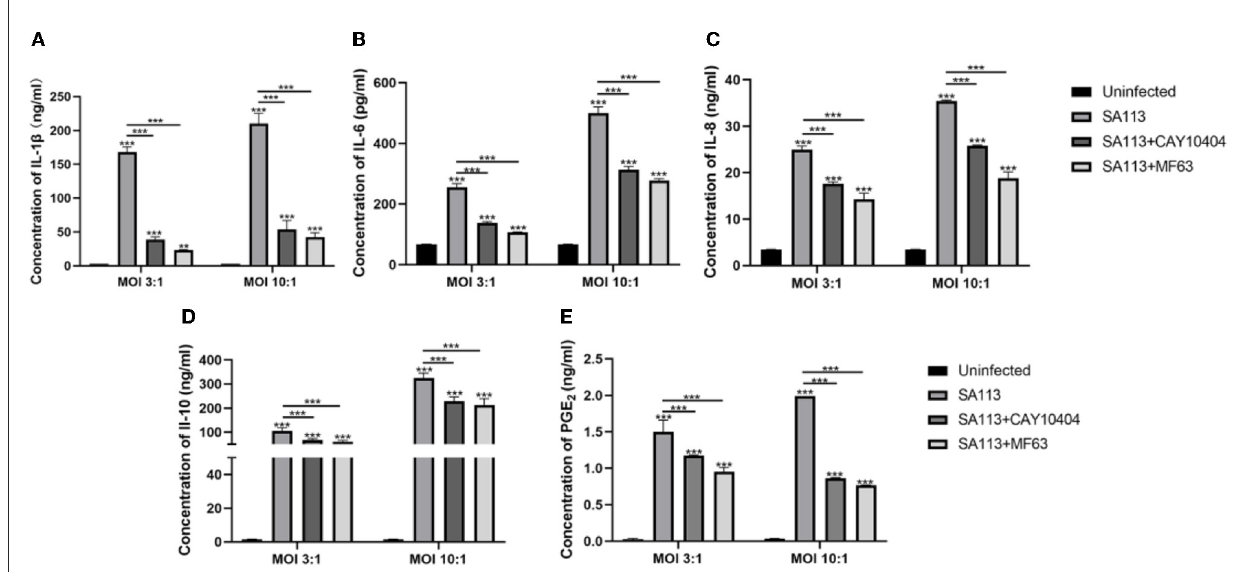
FIGURE6 PGE 2 can affect the secretion of pro-inflammatory factors, anti-inflammatory factors, and chemokines in neutrophils of cows infected with S. aureus . ELISA results showed that IL-1 β (A) , IL-6 (B) , IL-8 (C) , IL-10 (D) , and PGE 2 (E) were secreted in the SA113 group, the uninfected group, the CAY10404 group, and the MF63 group. ns P > 0.05, * P < 0.05; ** P < 0.01; *** P <